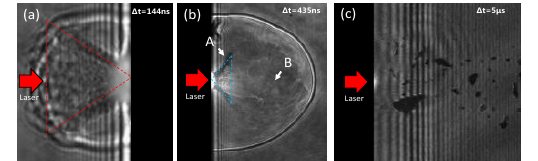
Fig. 6. The transient images of material ejection, from front surface (a), rear surface (b) and the debris ejection for longer